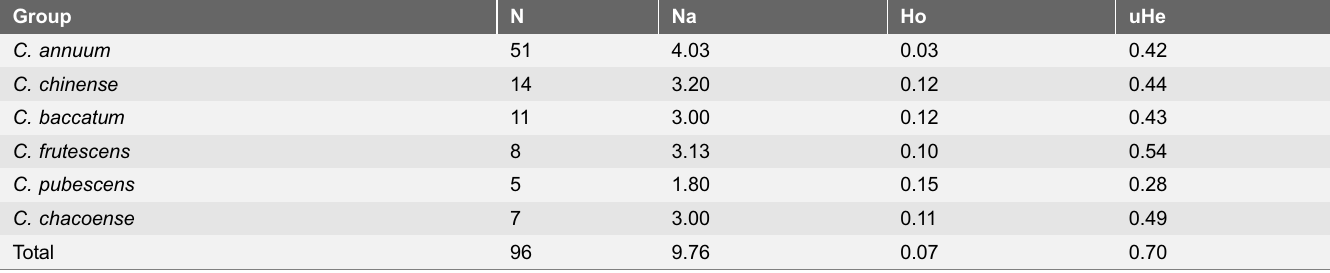
Table 1. Diversity parameters in the different Capsicum species and in the entire